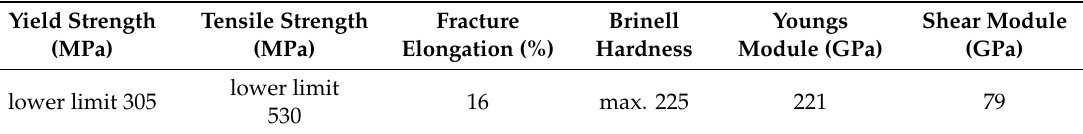
Table 3. C45—mechanical